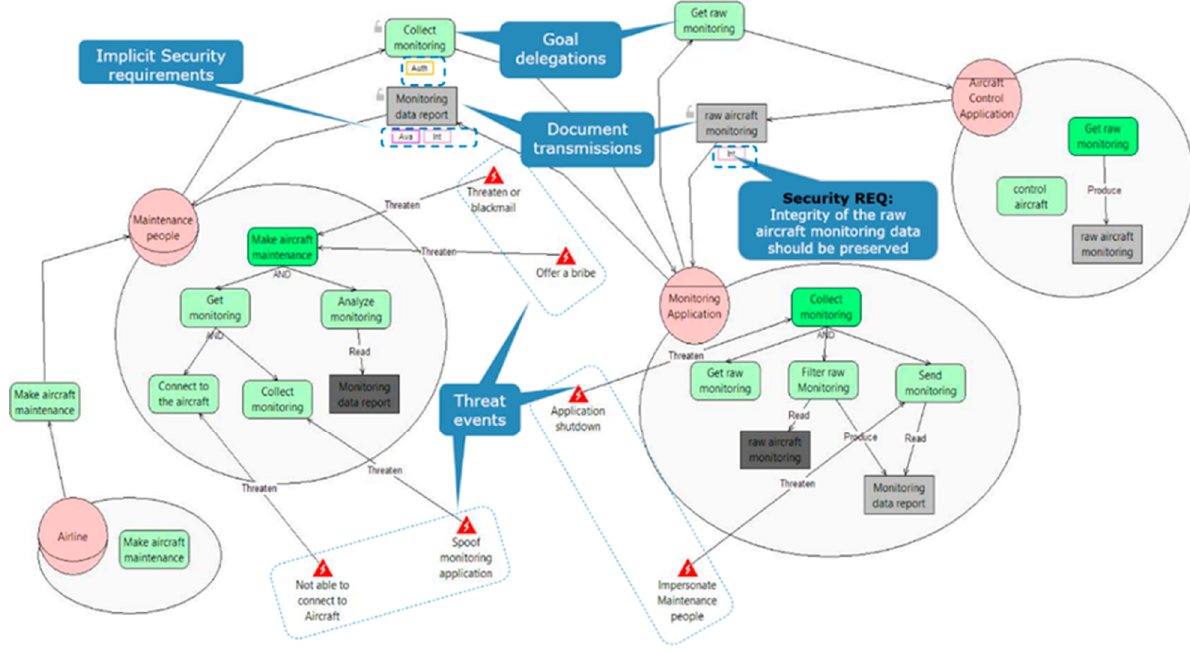
Figure 7. STS social view specification (sample).